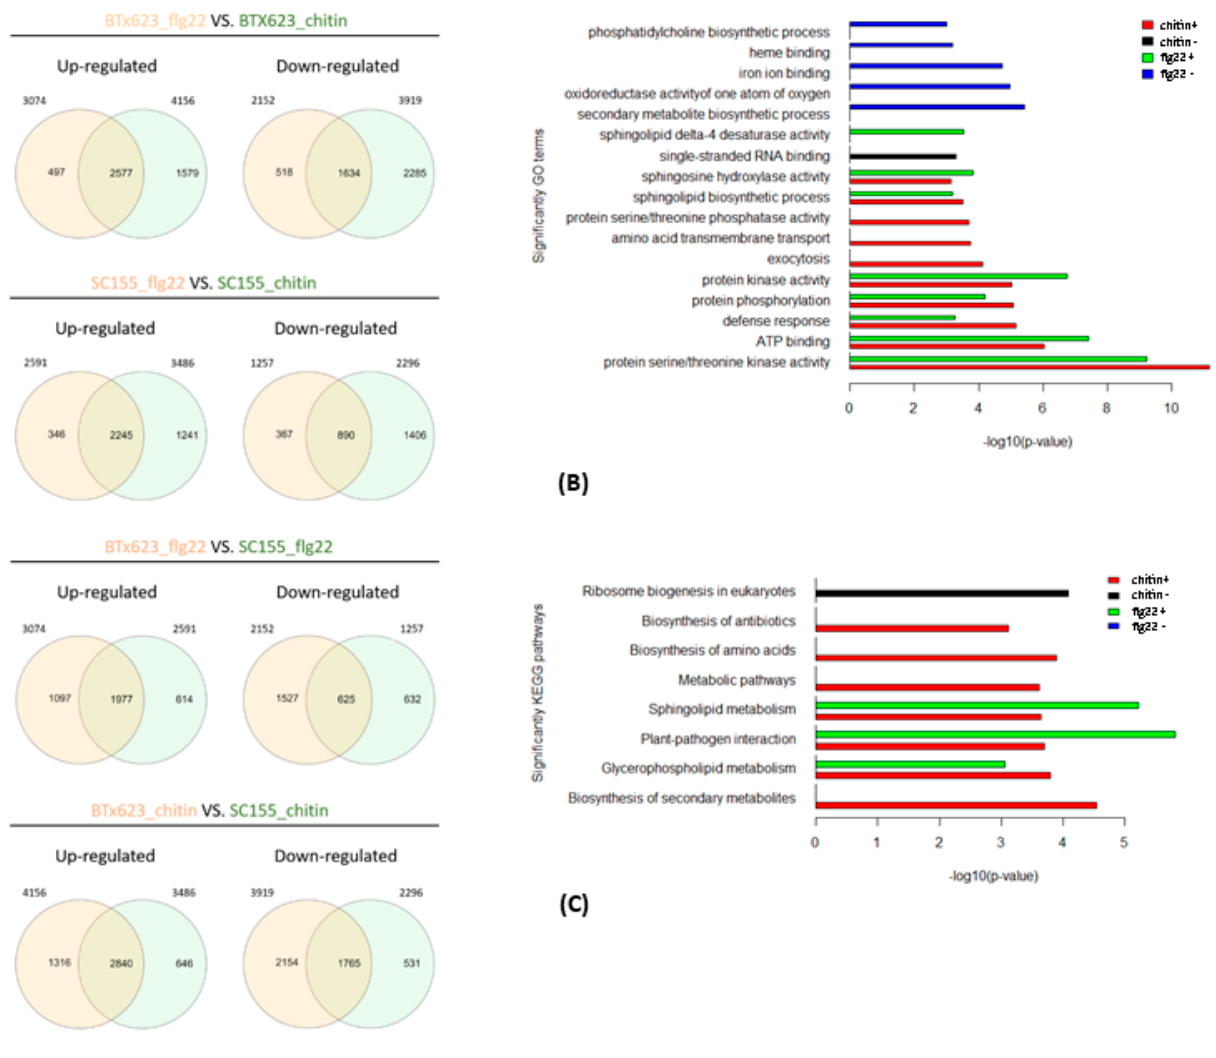
Figure 7. ( A ) Venn diagrams showing the pairwise overlap between the up-regulated and down-regulated genes of the indicated treatments. ( B ) Enriched GO terms of co-regulated genes between the BTx623 and SC155-14E after flg22 or chitin treatment (i.e., up-regulated or down-regulated in both genotypes) with p -values indicated on x-axes. ( C ) Enriched KEGG pathways of co-regulated sets of DEGs between the two genotypes after flg22 or chitin treatment with p -values indicated on x-axes.